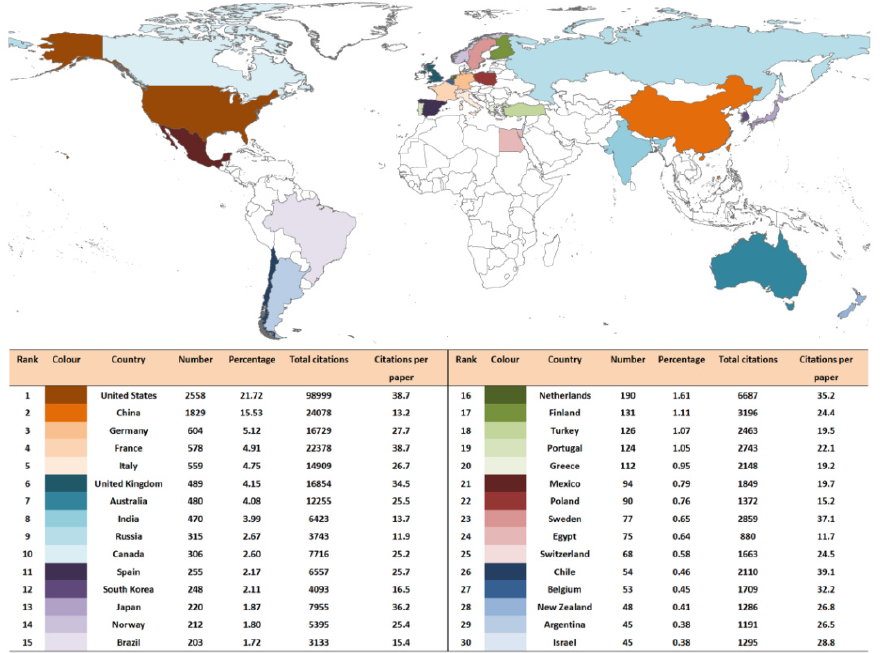
Figure 2. The distribution of the top 30 countries with publications in the area of ocean remote sensing research.